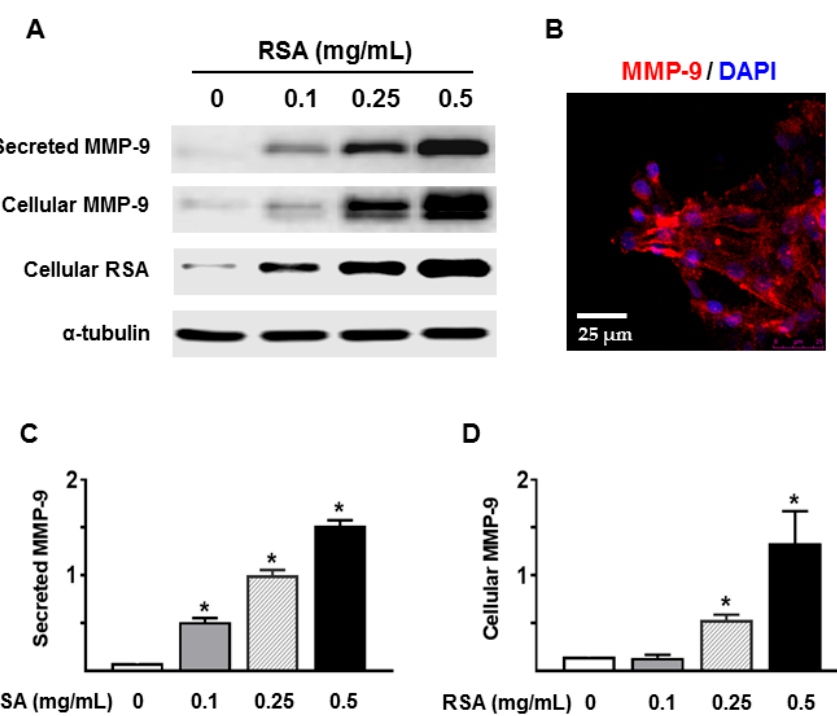
Figure 6. Albumin increased MMP-9 protein expression and secretion by primary rat TECs. Rat serum albumin (RSA 0.1–0.5 mg/mL) administration for 48 h resulted in a dose-dependent increase in MMP-9 protein in culture supernatants ( A , C ) and cell homogenates ( A , D ) of primary cultured rat TECs; ( B ) Representative confocal image shows MMP-9 signal is predominantly present on the cell surface of TECs. Values are mean ± SEM. n = 4; * p < 0.05 vs. untreated control